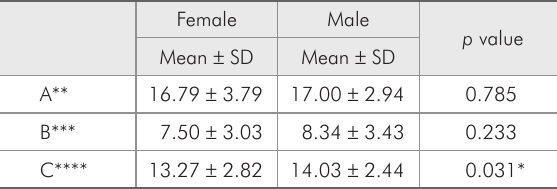
Table 2 - Measurements according to